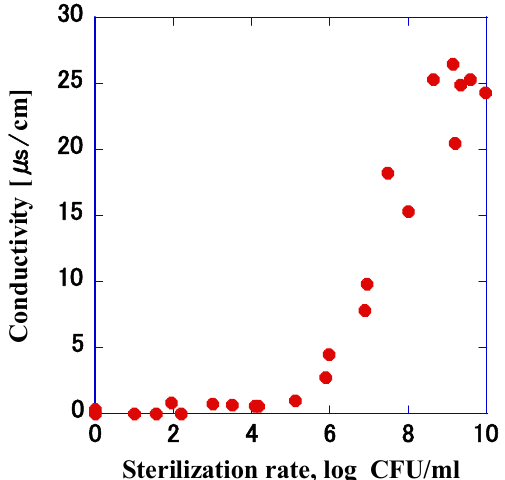
Figure 12. Relationship between the rate of sterilization and electrical conductivity obtained by impulse voltage application. There was a correlation between the conductivity and the rate of sterilization for conductivity >0.01 μ s/cm ( p > 0.05).